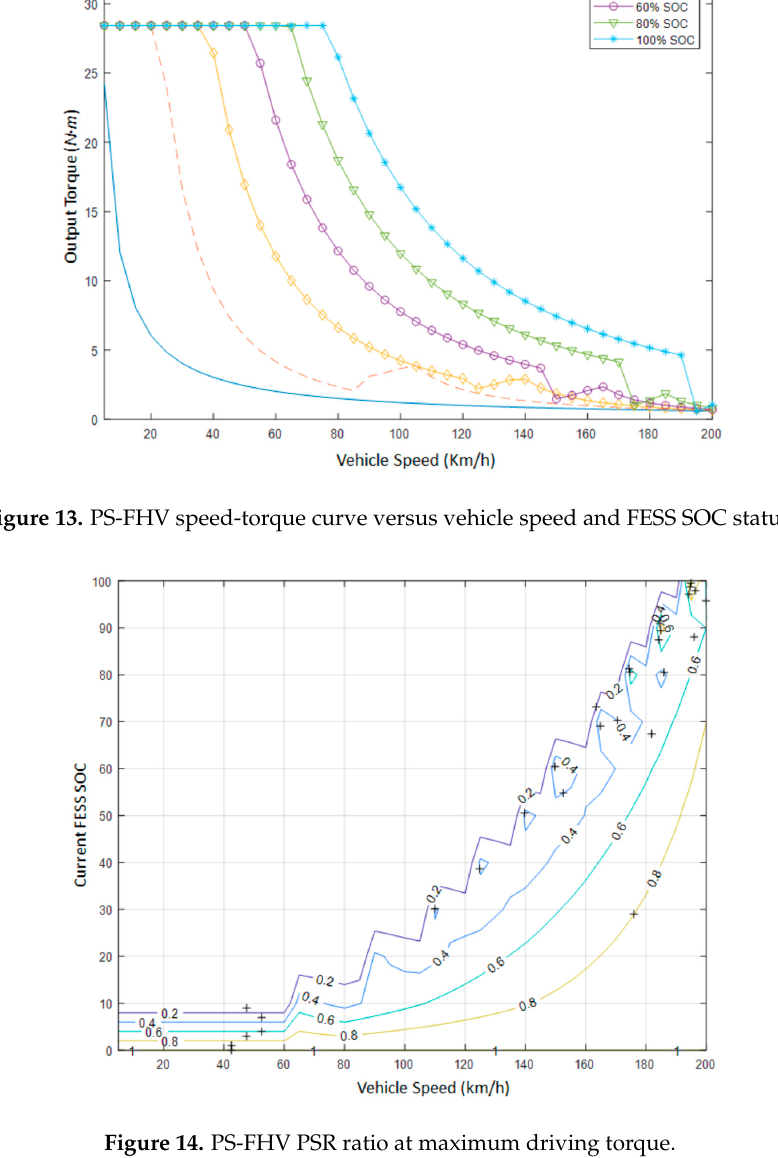
Figure 14. PS-FHV PSR ratio at maximum driving torque.